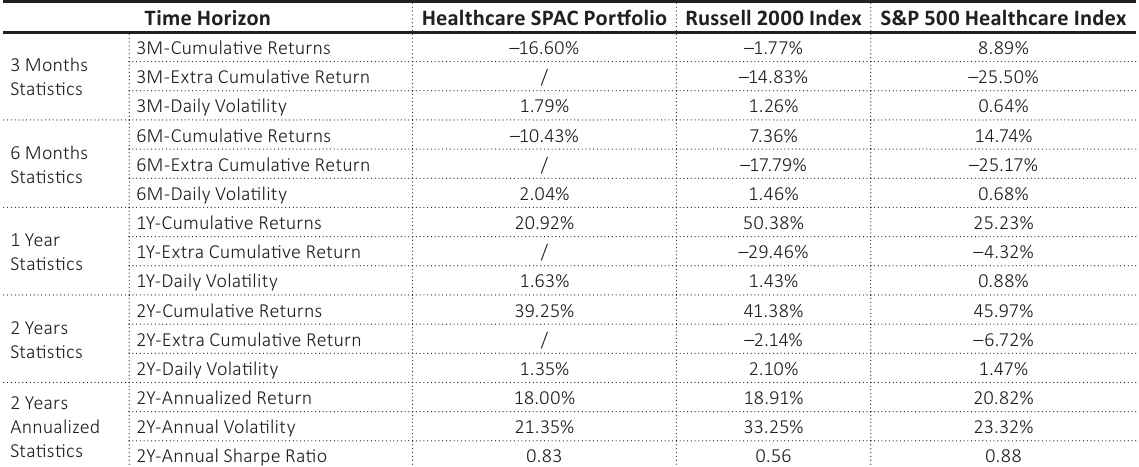
Table 2. Healthcare SPAC portfolio returns versus benchmarks